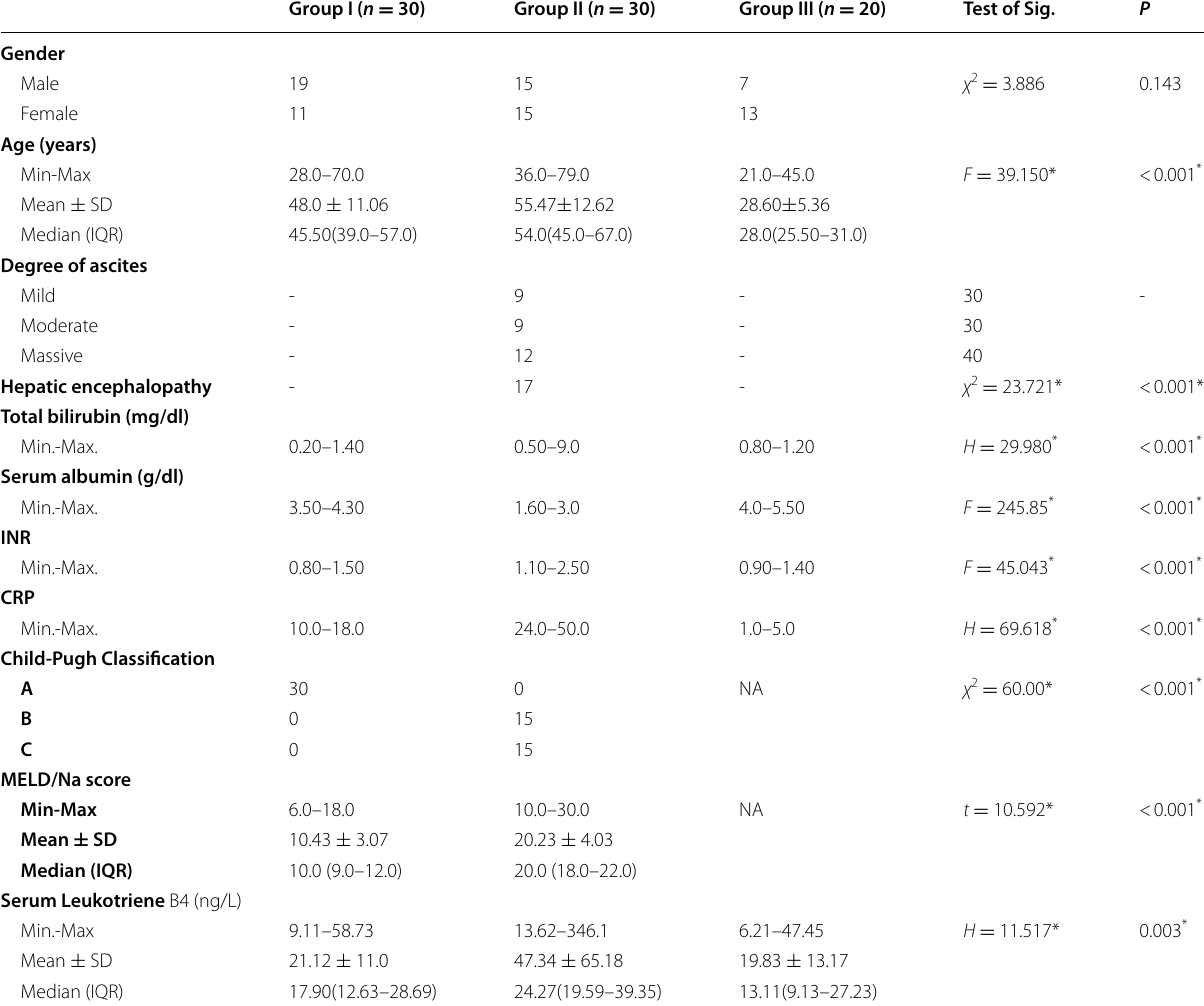
80) according to demographic data and other different =